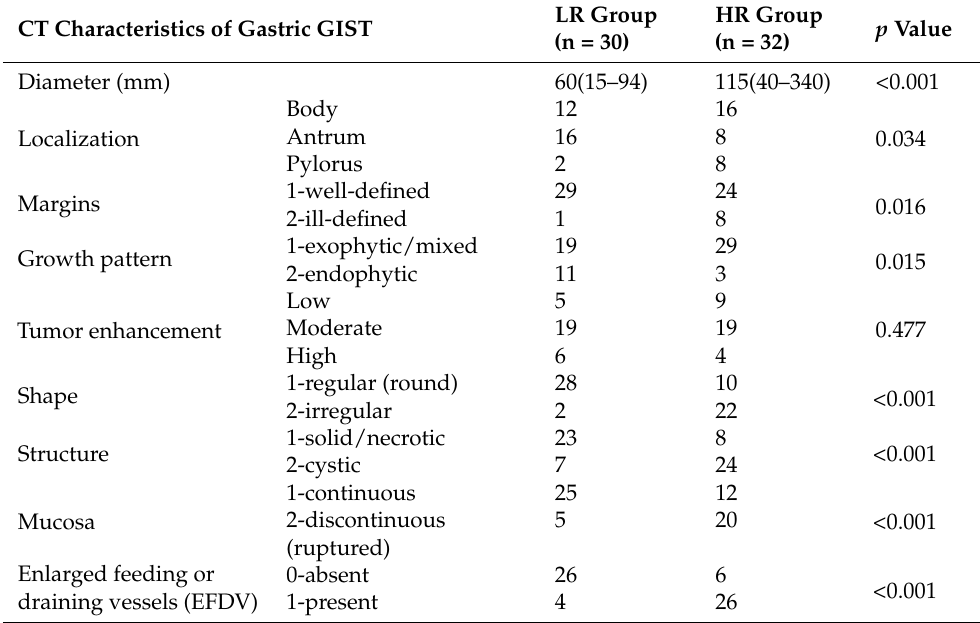
Table 1. Classical CT characteristics of gastric GIST in the HR and LR group.